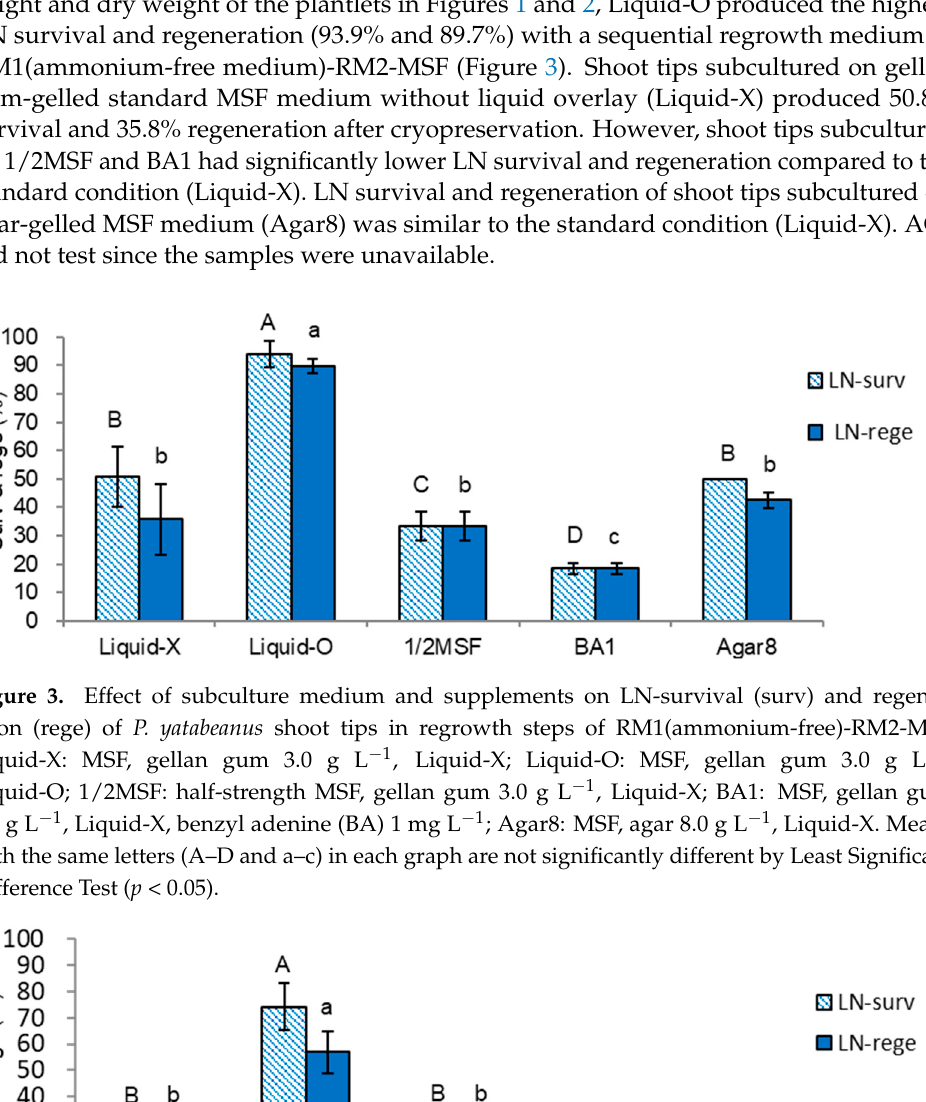
Table 1. The correlation coefficient between height and dry weight of donor plantlets subcultured once in the last cycle before cryopreservation (nine variants) and regeneration of subsequently cry- opreserved shoot tips. Treatment Sets